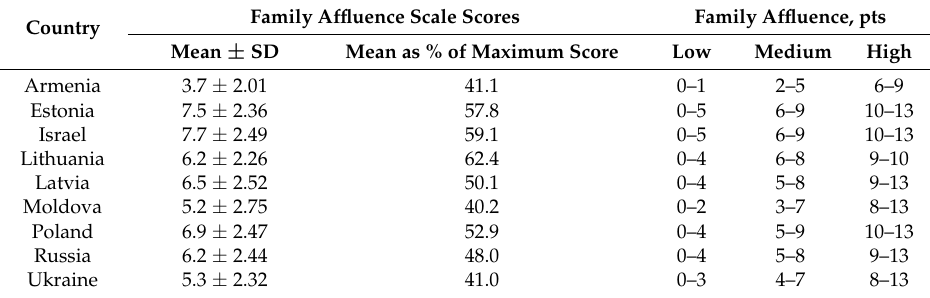
Table 3. Family affluence scores across analyzed